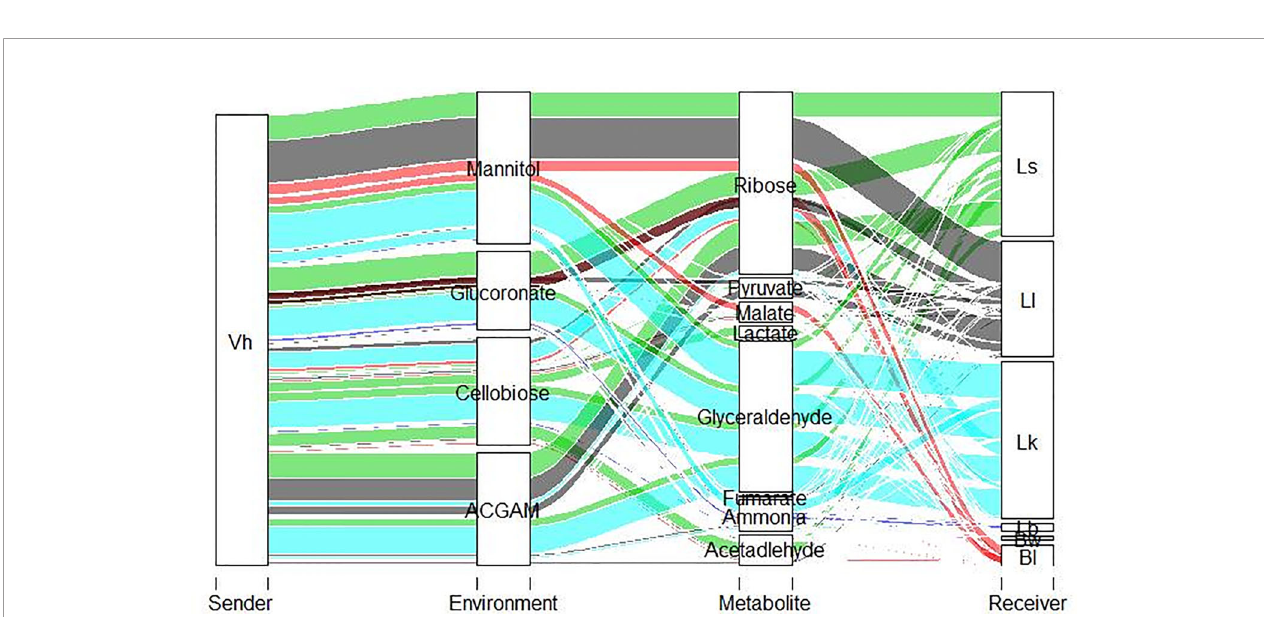
FIGURE 3 | Alluvial plot depicting top metabolites exchanged between shortlisted species and V. harveyi with thickness of the line denoting the SMETANA scores, which range between 0 and